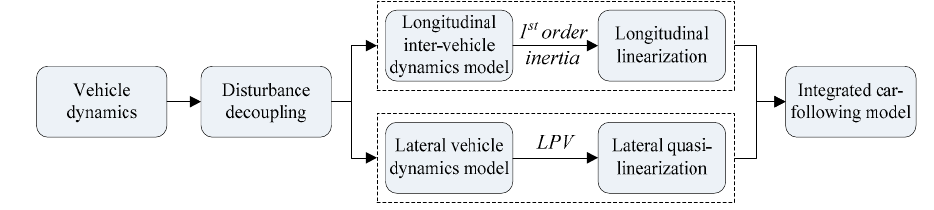
Figure 1. Flow chart of integrated car-following decoupling and linearization; LPV: linear Figure parameter-varying .